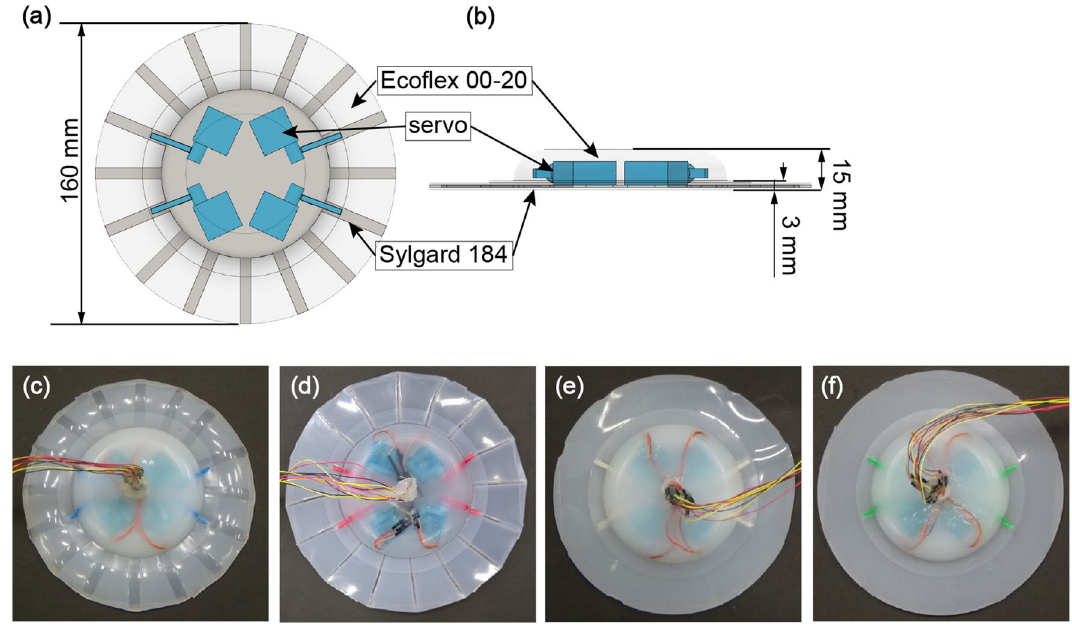
Figure 4. Overview of a developed robot consisting of a soft tissue (Ecoflex 00-20, Smooth-On), servomotors (FS 0403, FEETECH), and cartilages (Sylgard 184, Dow Corning): ( a ) top view of the robot structure; ( b ) side view of the robot structure; ( c ) the robot with flat cartilaginous; ( d ) robot with sharp cartilaginous; ( e ) robot made of homogeneous soft material; ( e ) robot with homogeneous stiffness, made of the mixture of cartilage and soft tissue